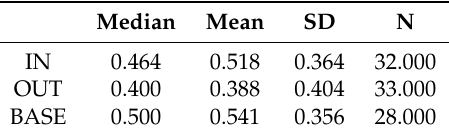
Table 1. Violation of proportionality.